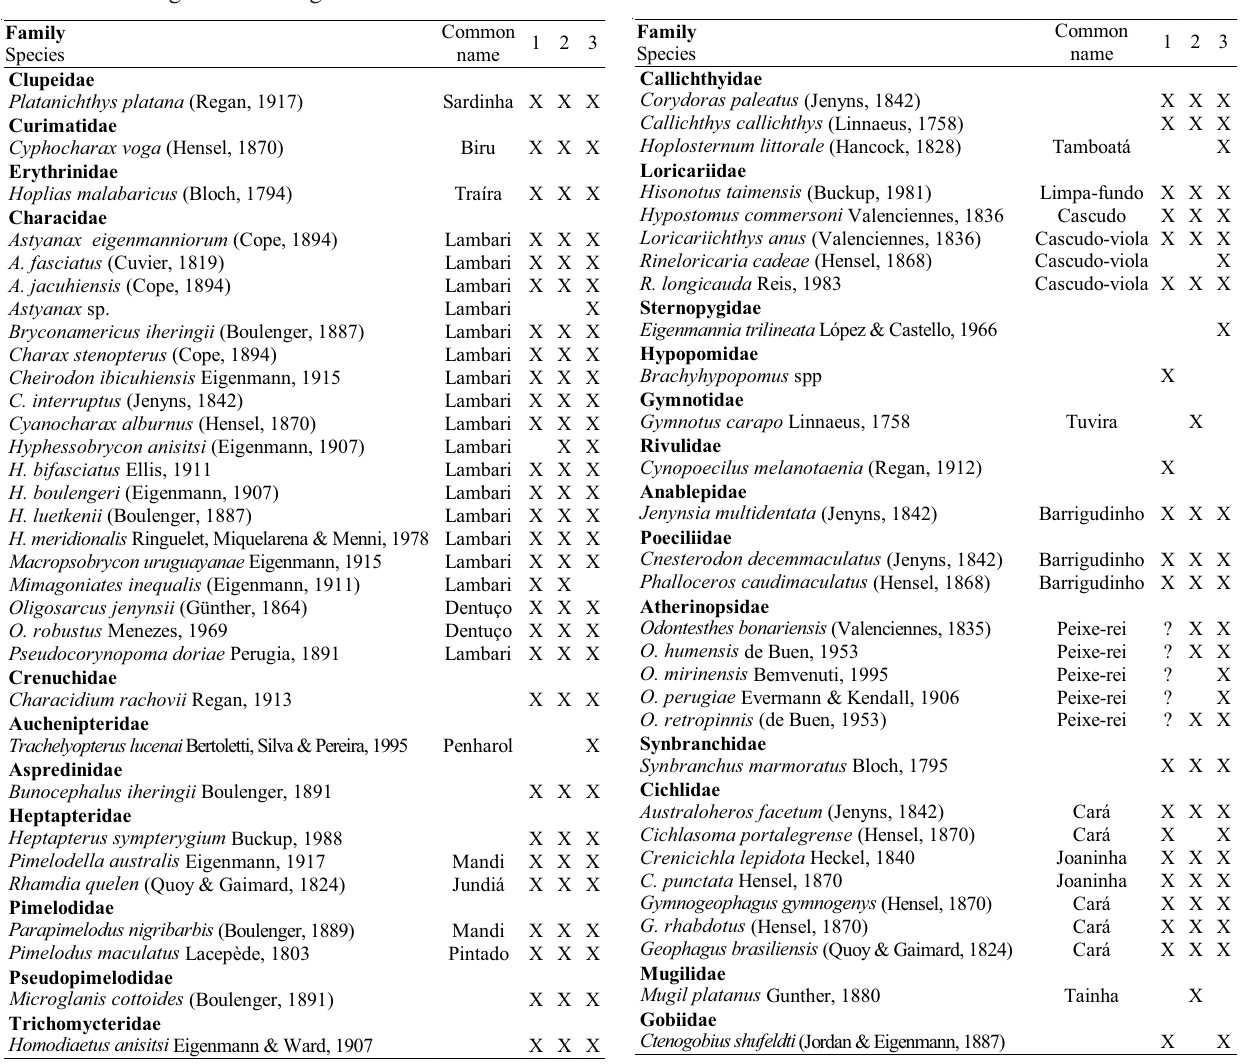
Table 1. Checklist comparison between fishes captured at the Taim Hydrological system during previous surveys (1.Buckup & Malabarba, 1983, from 1976 to 1981; 2.Grosser et al ., 1994, from 1985 to 1986) and the present study (3. from 2001 to 2005). Common names given in